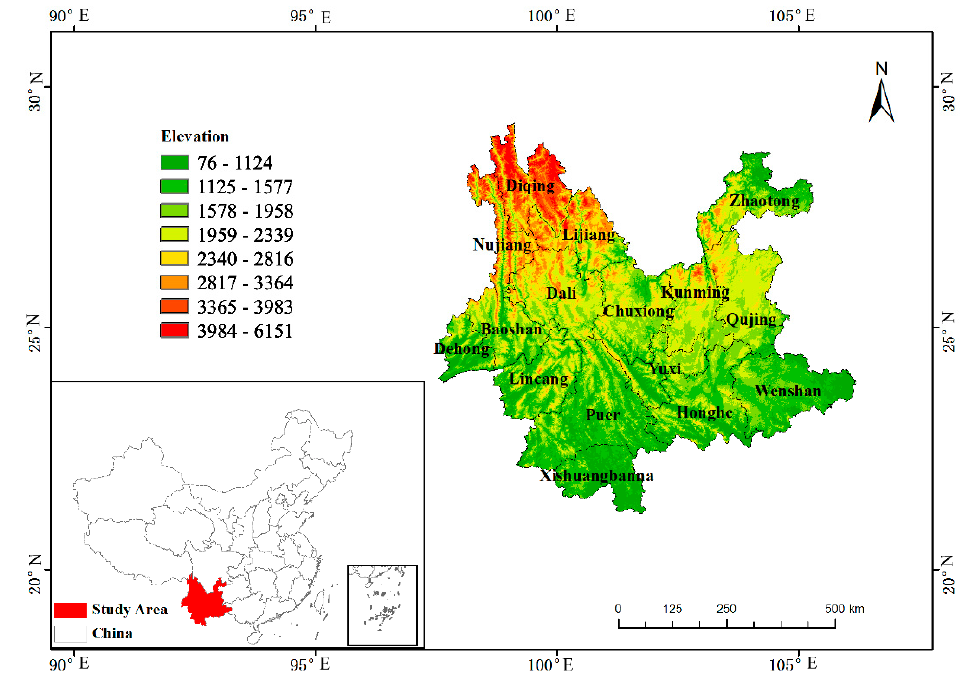
Figure 1. The location and topography of Yunnan Province.